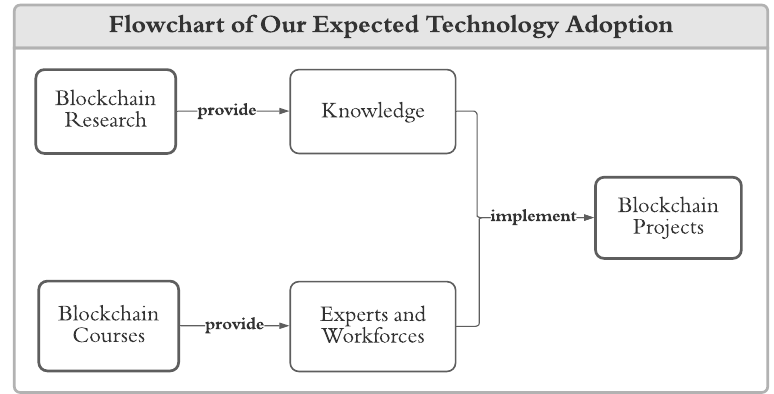
Figure 1. A flowchart of our expected technology